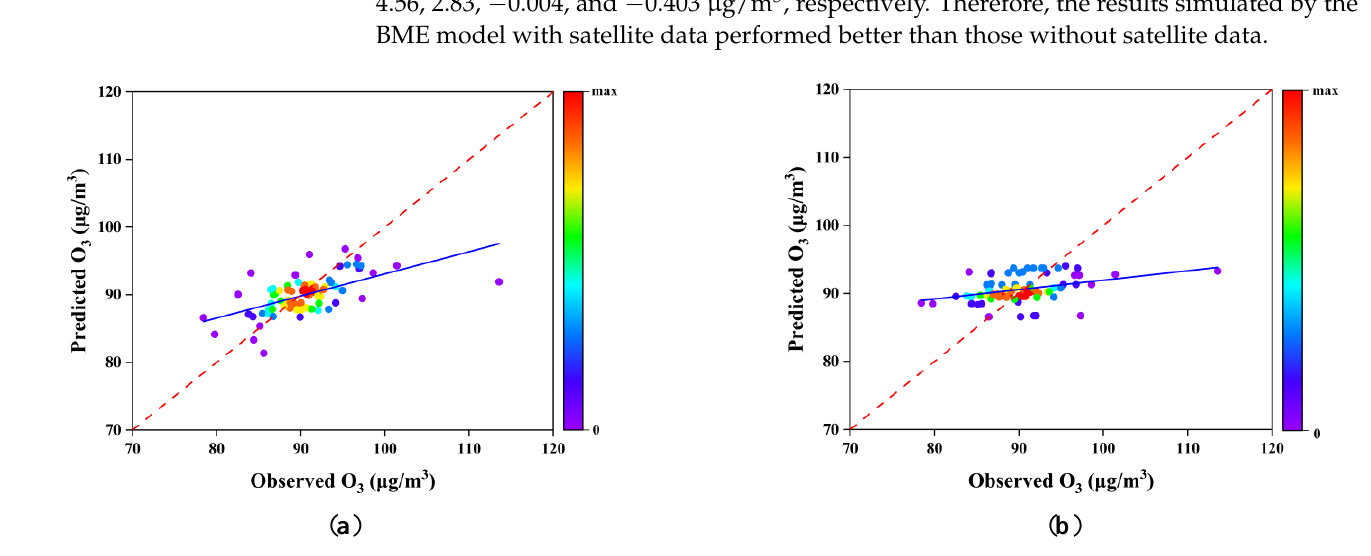
Figure 8. Scatter plot of observed and simulated annual maximum 8-h average O 3 concentration in the BTH region based on LOOCV ( a ) and leave-city-out validation ( b ). The dashed line is the 1:1 line, while the solid line is the linear regression. Table 2. LOOCV and leave-city-out validation results of BME estimations of annual O 3 concentrations. Validation